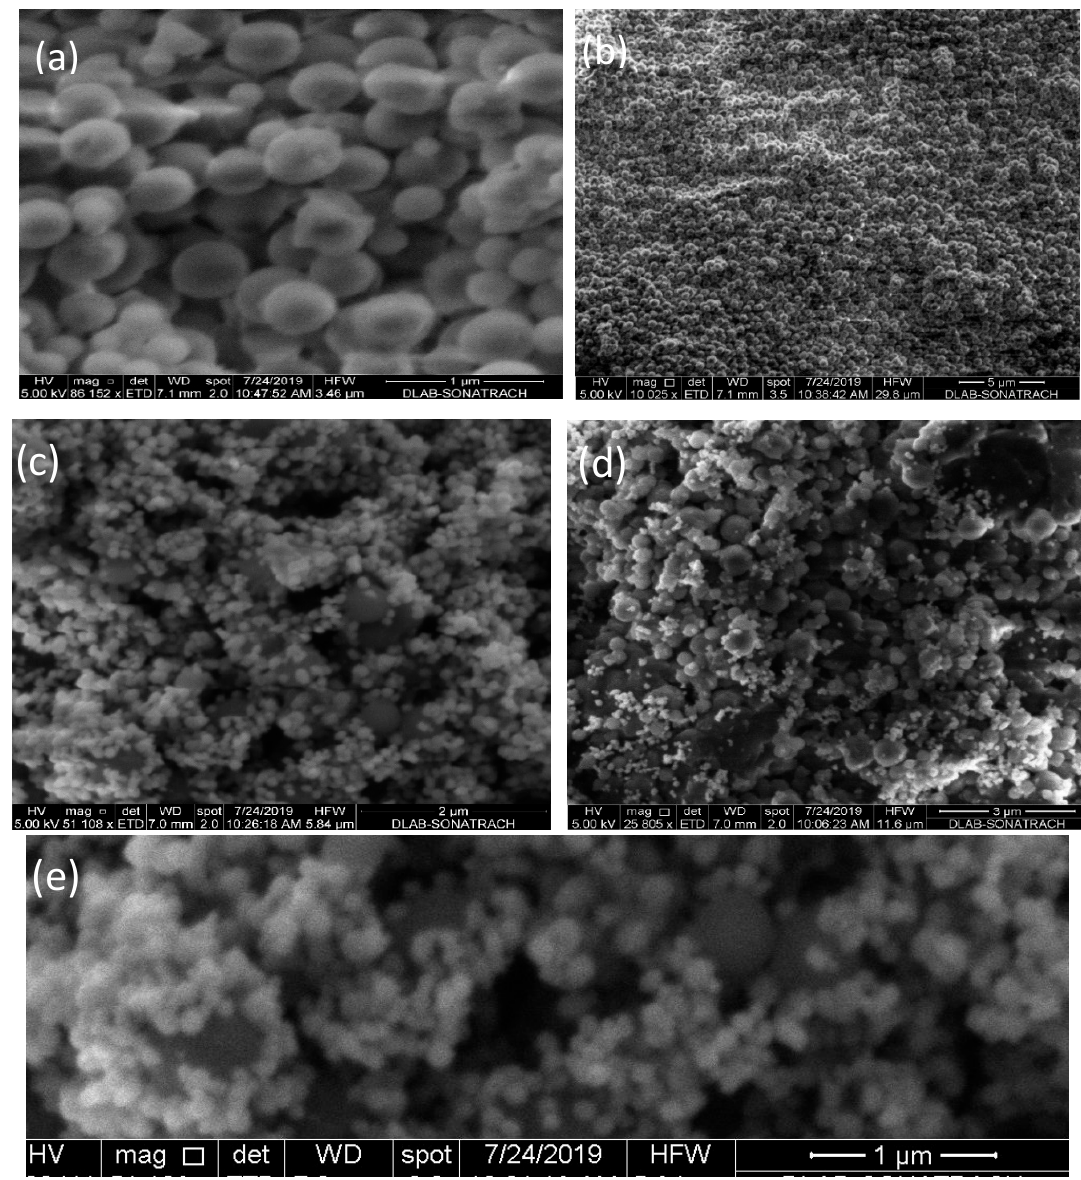
Figure 4. Scanning electron microscope (SEM) images of ( a , b ) CMS and ( c – e ) Fe 2 O 3 -CMS.